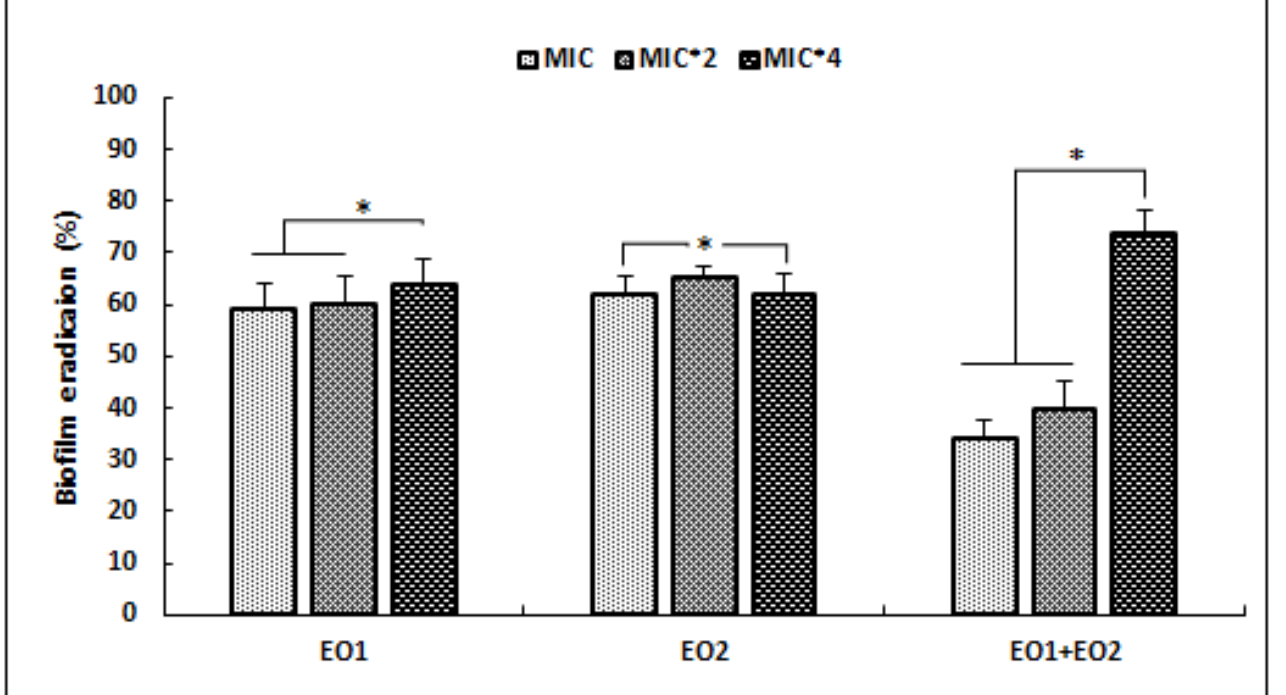
Figure 1. Effects of R . officinalis (EO1) and M. communis (EO2) essential oils and their combination (EO1 + EO2) on the reduction of preformed biofilm of S. aureus ATCC 25923, expressed as eradication percentages (%) and evaluated by the Crystal Violet staining assay. Values are the average of at least three independent determinations. Error bars represent standard deviations. (*) Differences were considered significant at p < 0.05.